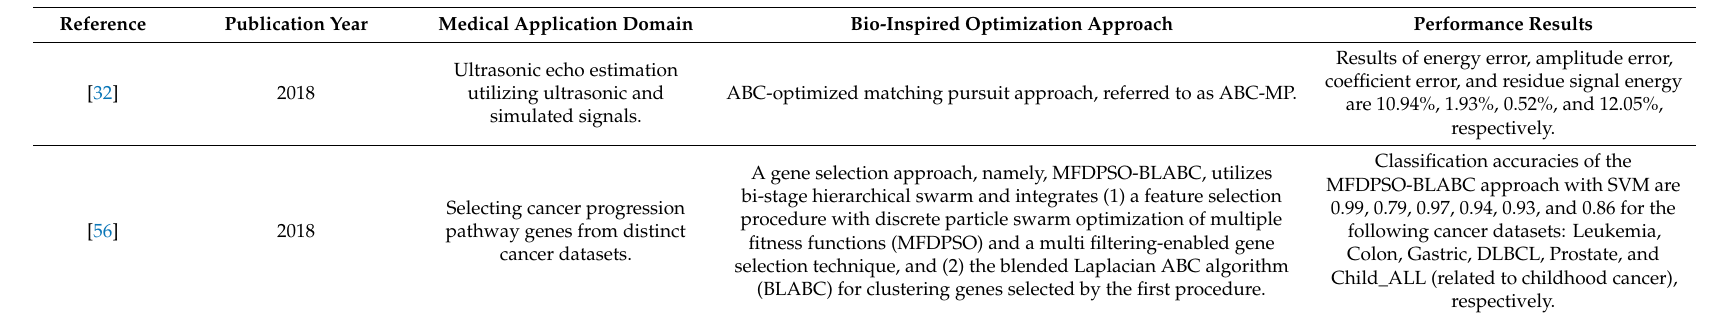
Table 3. Recent state-of-the-art bio-inspired optimization approaches utilized in medical